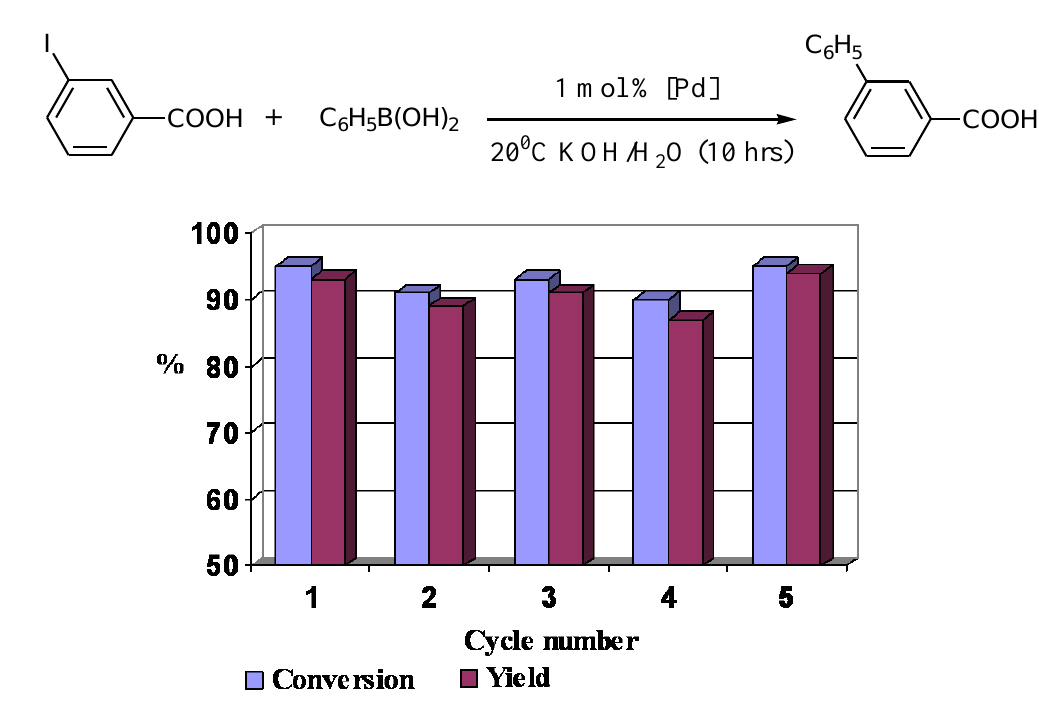
Figure 3. Recycling the catalyst in water after an ultrafiltration